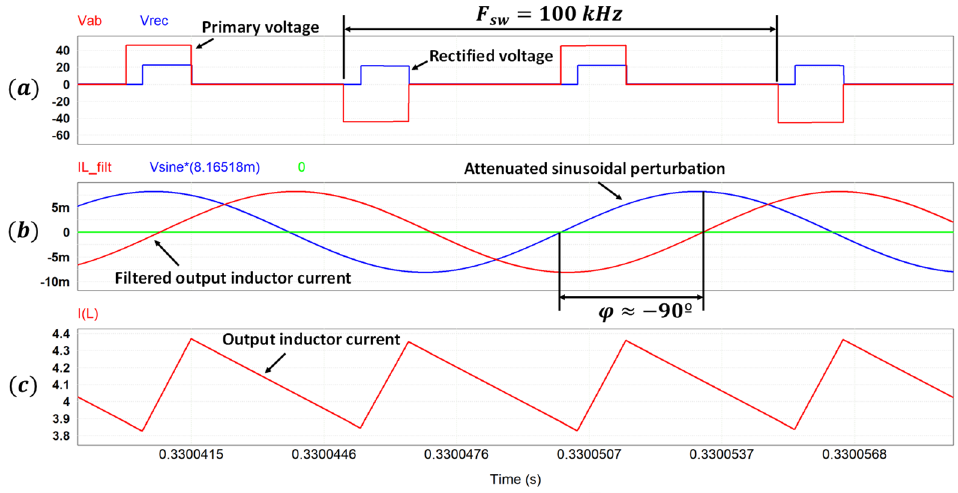
Figure 7. Simulation results of Test 1. ( a ) Primary and rectified voltage. ( b ) Attenuated sinusoidal perturbation and output inductor current after bandpass filter. ( c ) Output filter inductor